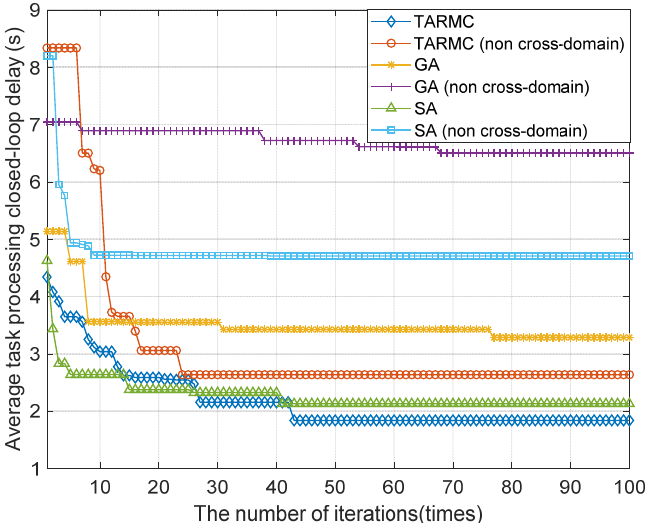
Figure 2. Variations in closed-loop delay of task processing under various resource allocation policies. The trend of variations in average energy consumption between multiple resource allo- cation strategies is discussed herein. In Figure 3, the horizontal axis represents the number of iterations, and the vertical axis denotes the average energy consumption. Furthermore, the plots with diamond, circular, star, vertical, triangular, and rectangular curves represent the TARMC strategy, TARMC strategy under non-cross-domain networks, GA strategy, and GA strategy under non-cross-domain networks, SA strategy, and SA strategy under non-cross-domain networks, respectively. As observed, the average energy consumption of the TARMC, GA skimming and SA strategies under cross-domain networks is